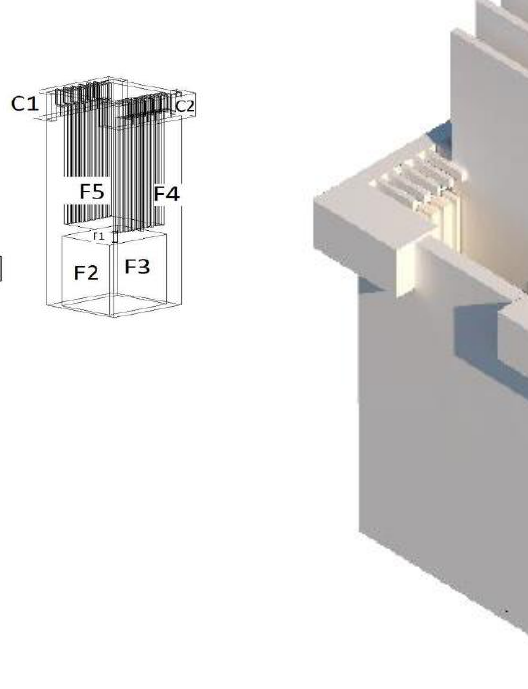
Figure A3. Assembly of the Equipment with the